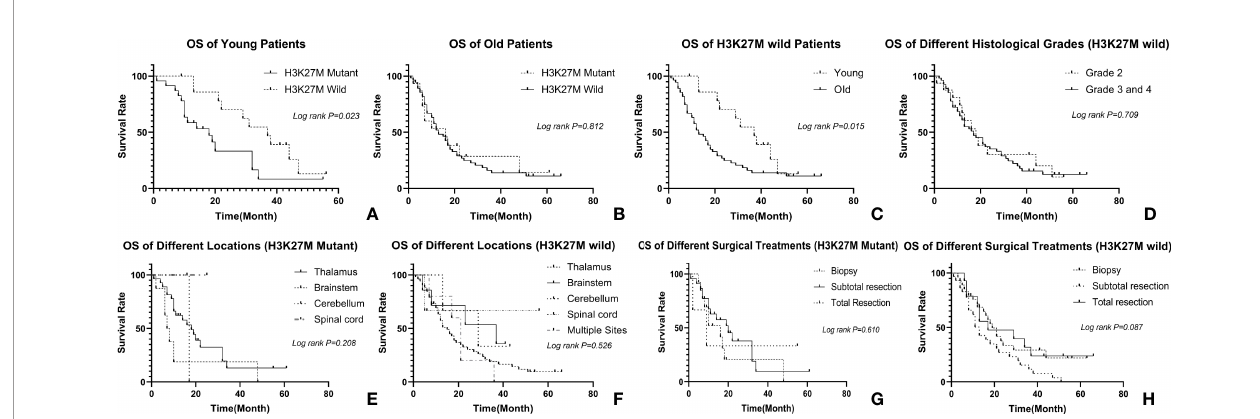
FIGURE 3 | Relationship between clinicopathological factors and OS: (A) relationship between H3K27M and OS in young patients, the H3K27M mutant had a worse prognosis; (B) relationship between H3K27M and OS in old patients, there is no difference in prognosis of two different subgroups; (C) prognosis of different age groups in H3K27M wild patients, the young has a better prognosis. (D) relationship between histological grade and OS in H3K27M wild patients. There is no difference in different histological grades; (E, F) relationship between tumor location and OS in patients, tumors in different location have similar prognosis regardless of H3K27M mutation; (G, H) relationship between operation and OS in patients, patients underwent biopsy, subtotal resection or total resection have similar prognosis regardless of H3K27M